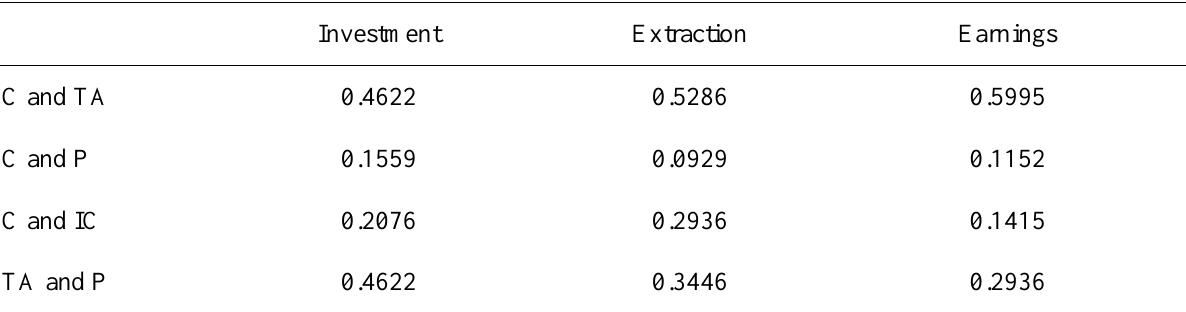
Table A3.3. p-values of Mann–Whitney test results for differences in investments, extraction level and earnings between different treatments during 8 treatment